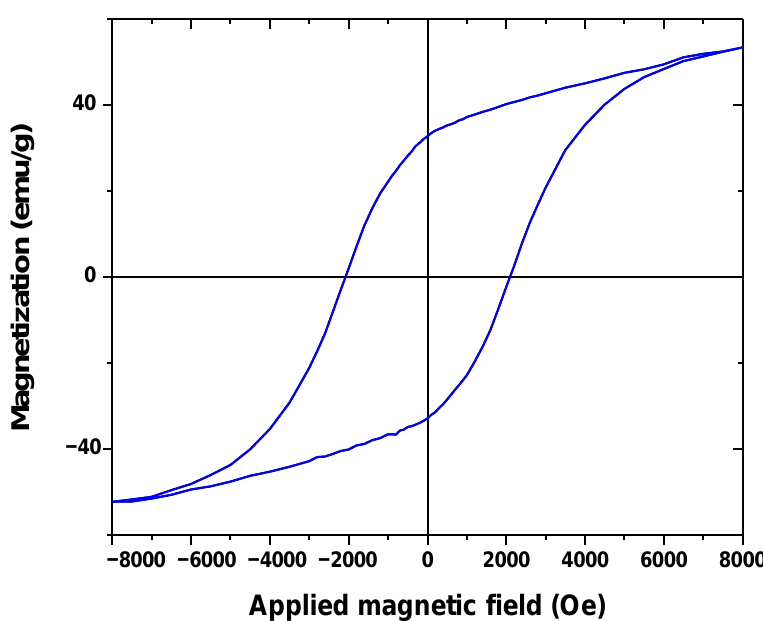
Figure 4. VSM plot of BFO/CFO@PEG nanocomposites.